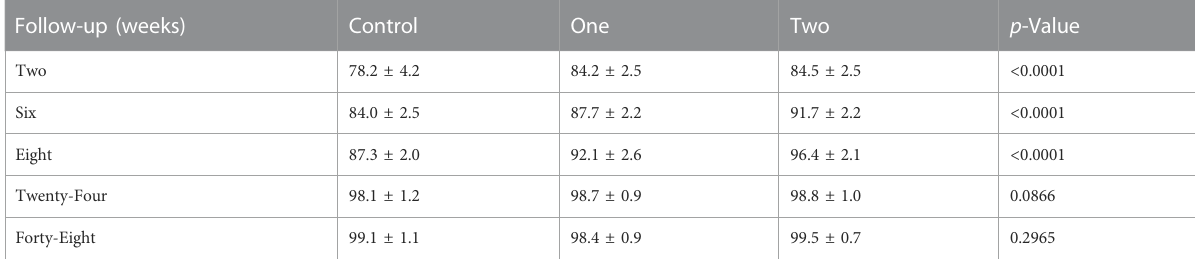
the mainstay of therapy (Doherty et al., 2017). PRP has been described for the treatment of ankle sprains in high- performance athletes as well as the general population. In the study by Juancarlos et al., the use of PRP therapy as an adjuvant for the treatment of lateral ankle sprains results in less discomfort and a better functional outcome when compared to immobilization alone (Rivera et al., 2020). However, the functional scales assessed are based only on the perspective of the patient and might provide subjective fi ndings; also, no radiographic evaluation (MRI or ultrasound) of the in fl uence of PRP on ATFL quality was done. Another study described a case of LAS with full ATFL rupture that exhibited complete ligament repair and early ankle stability following PRP. The healing is supported by dynamic ultrasound images and MRI. They indicated that in the future, PRP might be used as an alternative non-surgical treatment option in LAS, with the potential to avoid the development of CAI and post-traumatic ankle osteoarthritis (PTOA) (Lai and Sit, 2018). However, the evidence in this